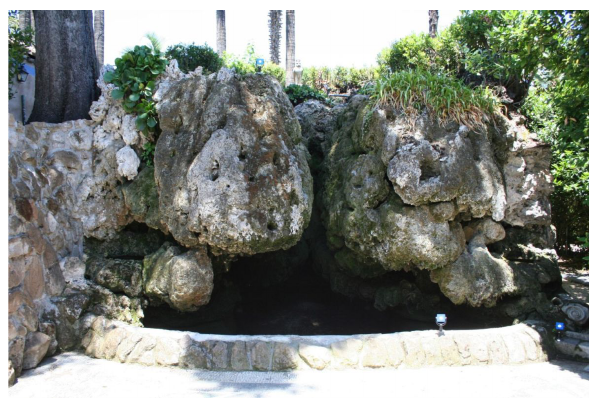
Figure 1. The “Fontana